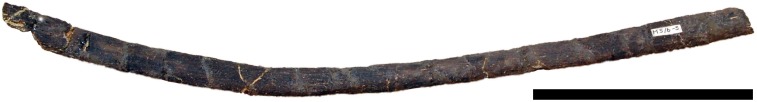
Sternal rib of Galeamopus pabsti SMA 0011.This bone can be attributed to morphotype C of Tschopp & Mateus (2013a). Orientation unknown, both ends lacking. Scale bar = 10 cm.